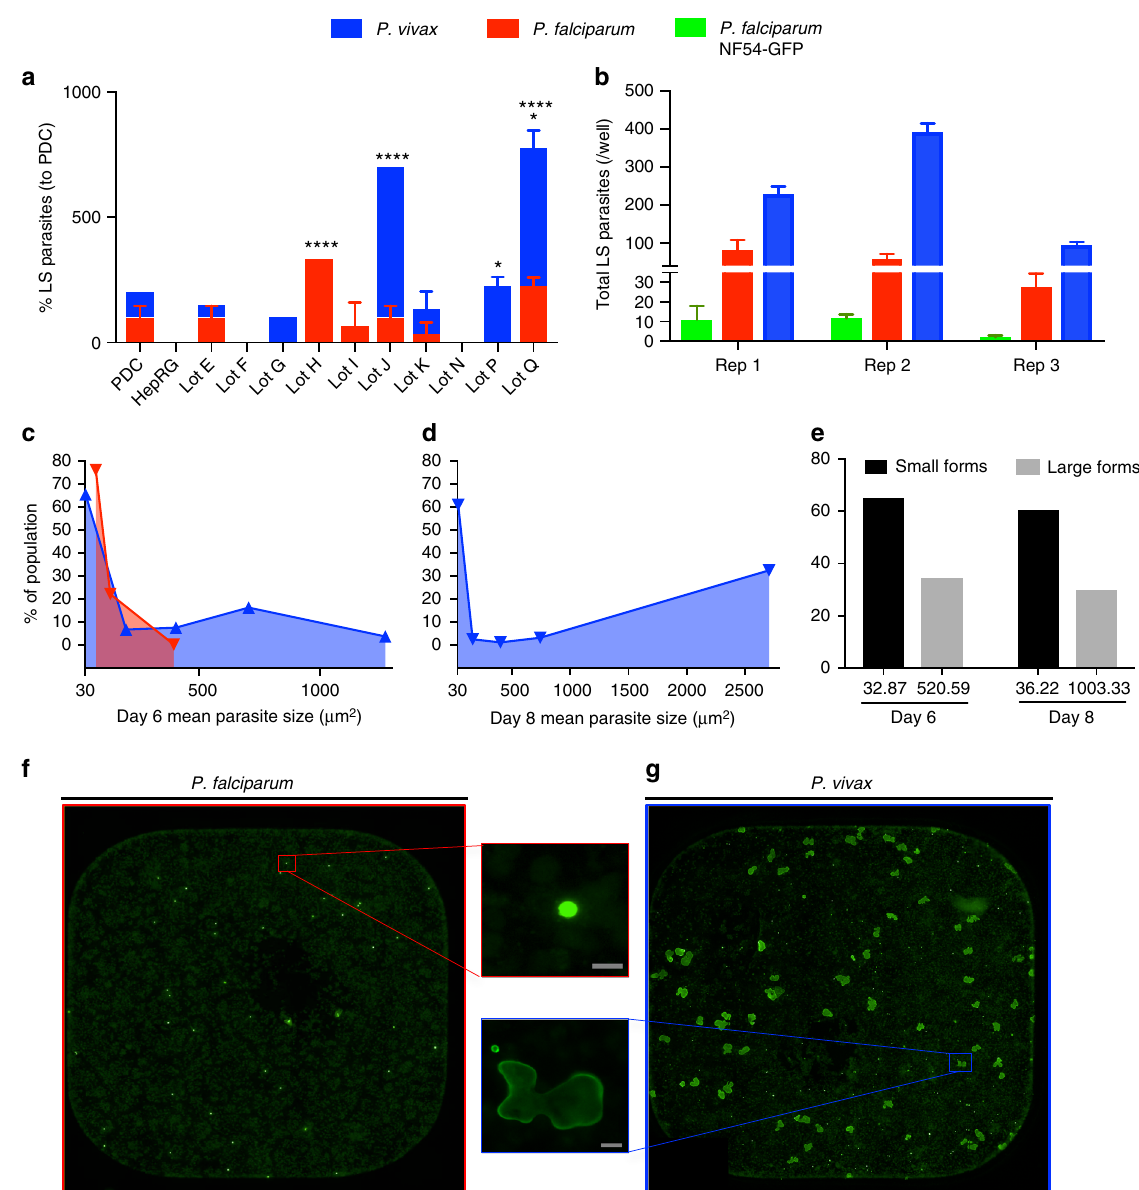
Fig. 3 Characterizing Plasmodium developmental phenotypes in the primary human hepatocyte (PHH) culture system. a A total of ten cryopreserved PHH donor lots were screened for infectability and liver stage (LS) development by cryopreserved P . vivax and P . falciparum sporozoites in comparison to donors PDC and differentiated HepaRG line. Four donors (lot H, J, P, and Q) were signi fi cantly higher in percent of LS parasites relative to PDC while two donors (lot F and N) showed no LS parasite growth. Alternatively, speci fi c donors appear to only be susceptible to a single Plasmodium species (lot G and P to P . vivax , lot H and I to P . falciparum ). b Plasmodium sporozoites were added to PHHs at 5000 sporozoites per well with P . vivax fi eld isolates showing highest LS development rates between 2 and 8.3%, P . falciparum NF54-WT between 0.6 and 2%, and P . falciparum NF54-GFP between 0.04 and 0.4%. c On day 6 of LS development, P . falciparum has a relatively synchronized growth with a large parasite population at a mean size of >100 µ m 2 . d , e P . vivax LS parasites have a larger distribution of size from day 6 to day 8 ( d ) with a consistent hypnozoite (~60%) to developing schizont (~40%) ratio in the total population ( e ). f , g Representation of a single 384-well view showing day 6 P . falciparum LS schizonts stained with anti-GAPDH (left) and day 8 P . vivax developing LS schizonts and dormant hypnozoites stained with anti-rUIS4 (right) imaged on the Operetta HCI system, Perkin Elmer. Graph bars represent means with s.d. from an independent experimental replicate ( n = 3, a ) or for biological replicates ( n = 3) with experimental replicates ( n = 3, b ). Statistical signi fi cance was determined using a two-way ANOVA followed by Dunnett ’ s multiple comparisons to PDC ( a , b ) where signi fi cance is represented by P < 0.05 (*) and P < 0.0001 (****). Plasmodium spp. mean parasite size distribution ( c – e ) was calculated from biological replicates ( n = 3) with experimental replicates ( n = 26, P . vivax ) or ( n = 8, P . falciparum ). Gray scale bars represent 10 µ